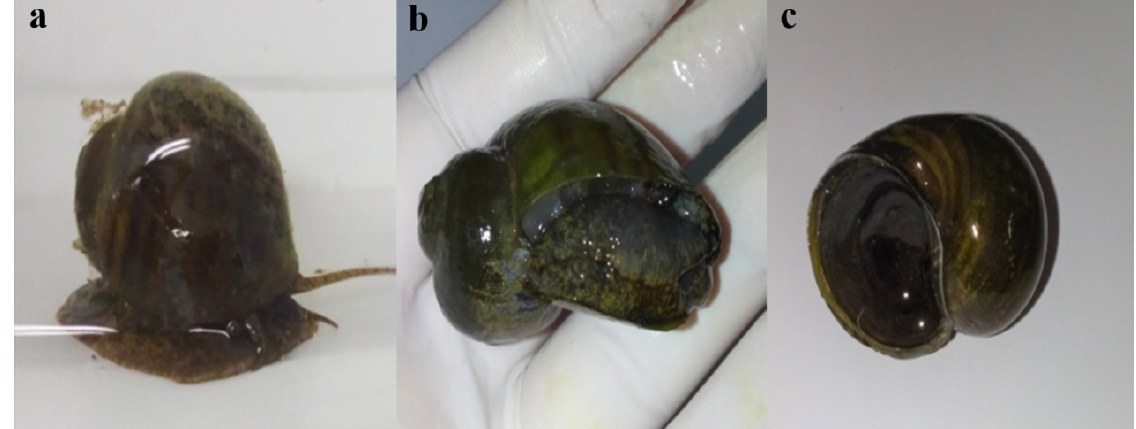
Figure 1. Different stages of Pomacea canaliculata exposed or not to substances with relaxing properties. (a) Normal stage or with essential oil without effect, (b) Relaxation stage, (c) Aversive-like effect observed for